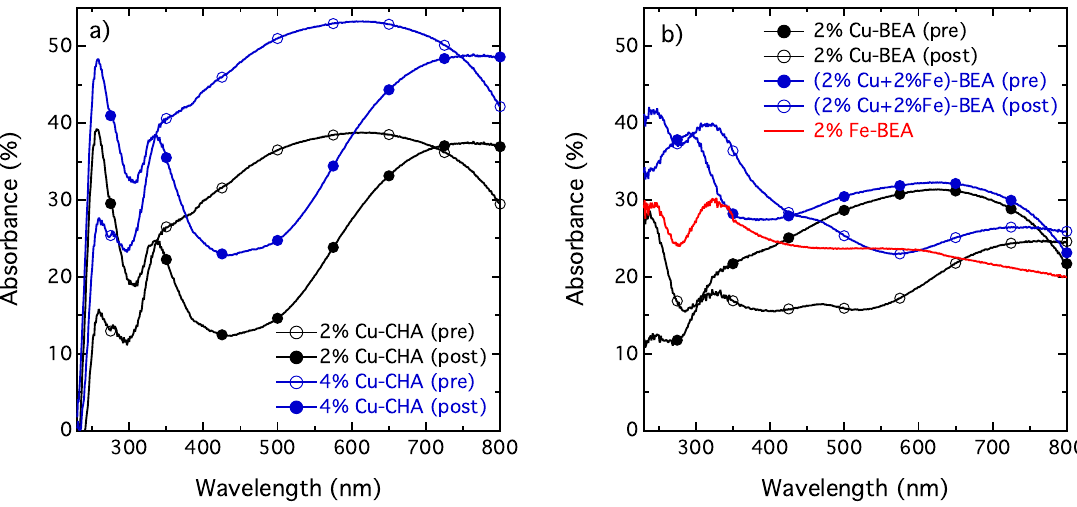
Figure 2. UV-Vis spectra for ( a ) 2% and 4% Cu-SSZ-13 samples before (pre) and after (post) the [NH 3 +NO]-SSIE, ( b ) 2% Fe-beta, 2% Cu-beta, and (2% Cu + 2% Fe)-beta samples before (pre) and after (post) the [NH 3